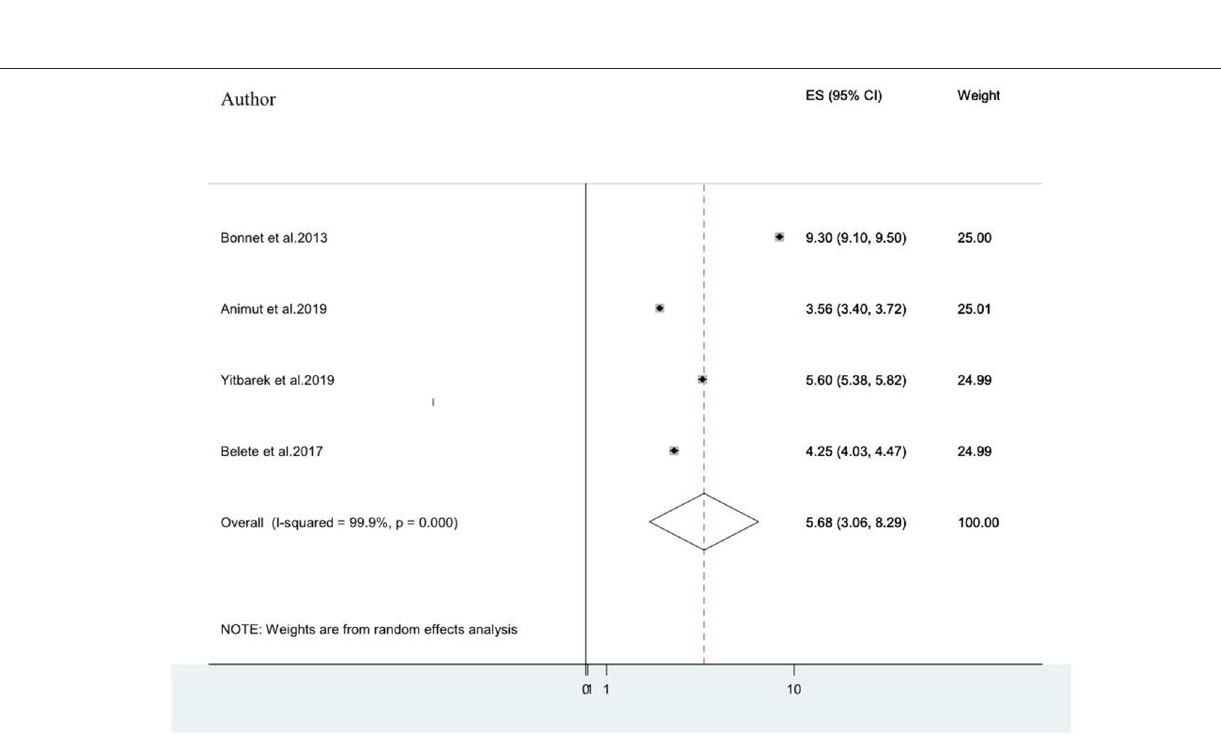
Frontiers in Psychiatry | www.frontiersin.org 15 May 2022 | Volume 13 | Article